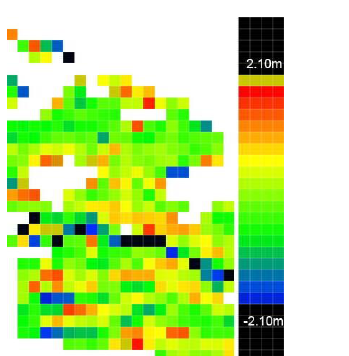
Figure 16. Systematic height errors of WorldView-2 DSM model 2 against LiDAR DSM; only for non-forest area without quarries